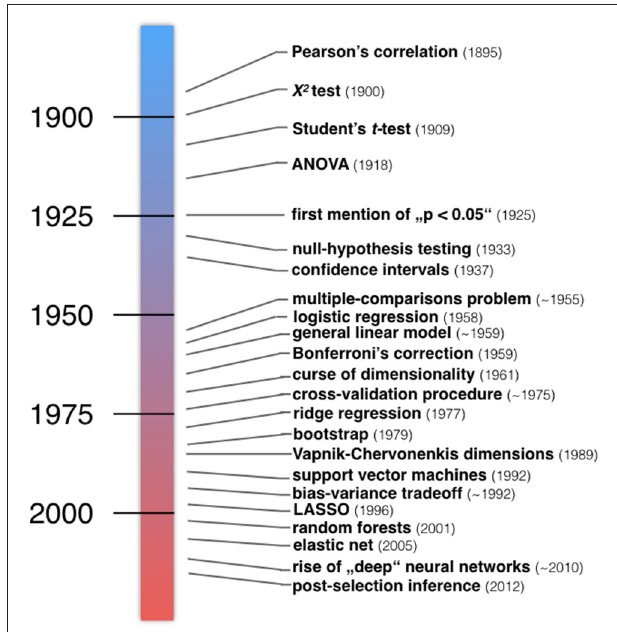
FIGURE 2 | Developments in the history of classical statistics and statistical learning. Examples of important inventions in statistical methodology. Roughly, a number of statistical methods taught in today’s textbooks in psychology and medicine have emerged in the first half of the twentieth century (blue). Instead, many algorithmic techniques and procedures have emerged in the second half of the twentieth century (red). “The postwar era witnessed a massive expansion of statistical methodology, responding to the data-driven demands of modern scientific technology.” ( Efron and Hastie,